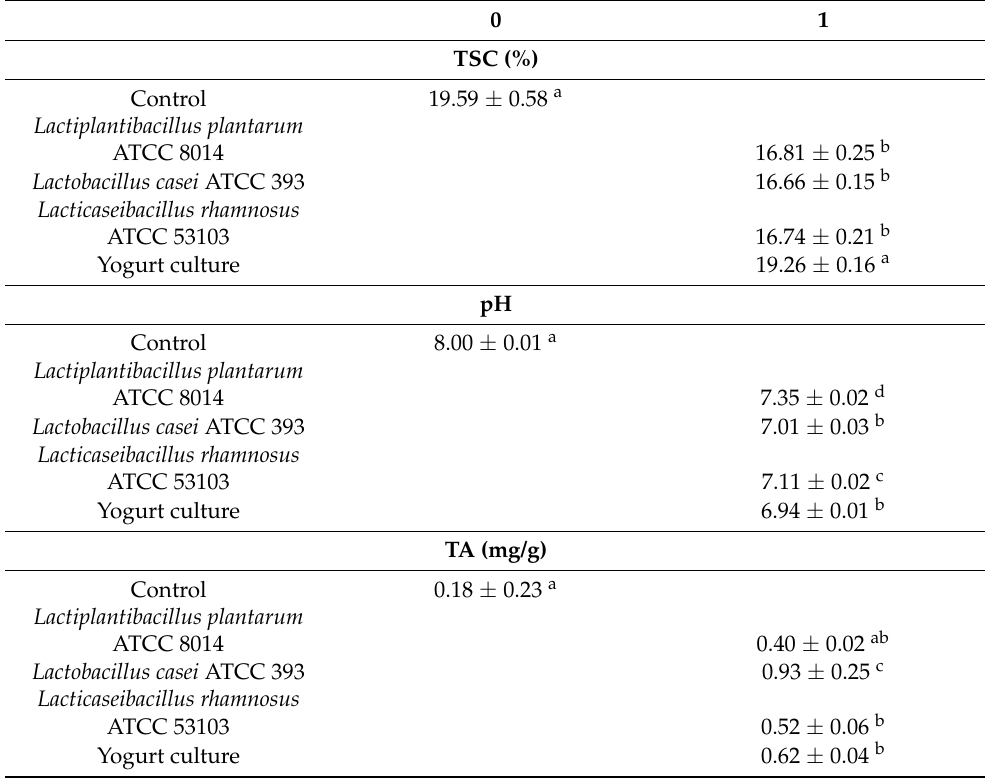
Table 1. Changes in total solid content (TSC), pH, and titratable acidity